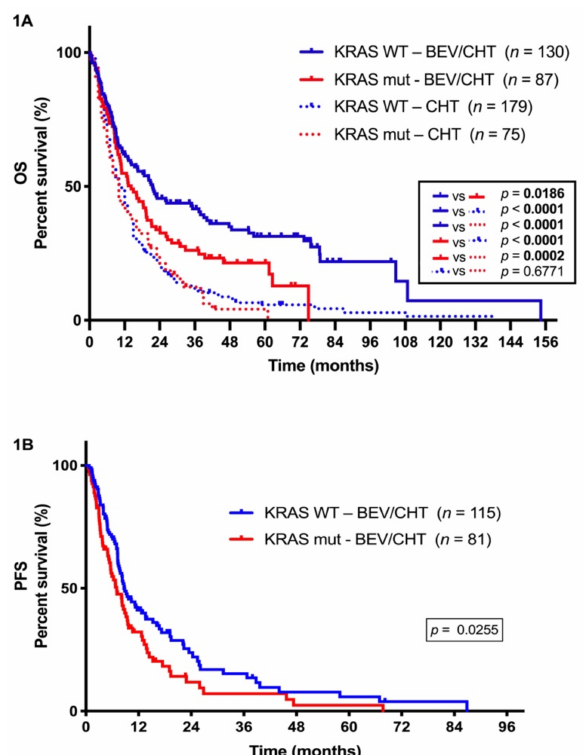
Figure 1. Kaplan-Meier plots for the overall survival (OS) ( A ) and progression-free survival (PFS) ( B ) in lung adenocarcinoma (LADC) patients according to V-Ki-ras2 Kirsten rat sarcoma viral oncogene homolog (KRAS) mutation status. ( A ) LADC patients with KRAS wild-type (WT) tumors and receiving bevacizumab / chemotherapy (BEV / CHT) had significantly increased median OS (vs. those with KRAS WT tumors and receiving CHT only; median OS 21.57 vs. 14.23 months, respectively, p = 0.0186, log-rank test). Median OS was also increased in KRAS-mutant LADC patients receiving BEV / CHT compared to those treated with CHT only (median OSs were 18 vs. 10 months, respectively, p = 0.0002, log-rank test). No significant di ff erences in OS have been observed for patients receiving CHT only and with KRAS WT versus KRAS-mutant tumors (median OSs were 11 vs. 10 months, respectively p = 0.6771, log-rank test). Of note, in the BEV / CHT group, patients with KRAS WT LADC had a significantly better OS than those with tumors harboring KRAS mutations (median OSs were 39 vs. 18 months, respectively, p = 0.0186, log-rank test). ( B ) Similarly, in the BEV / CHT group, patients with KRAS WT LADC had significantly longer median PFS (vs. those with KRAS-mutant tumors; median PFSs were 8.63 vs. 7.03 months, respectively, p = 0.0255, log-rank